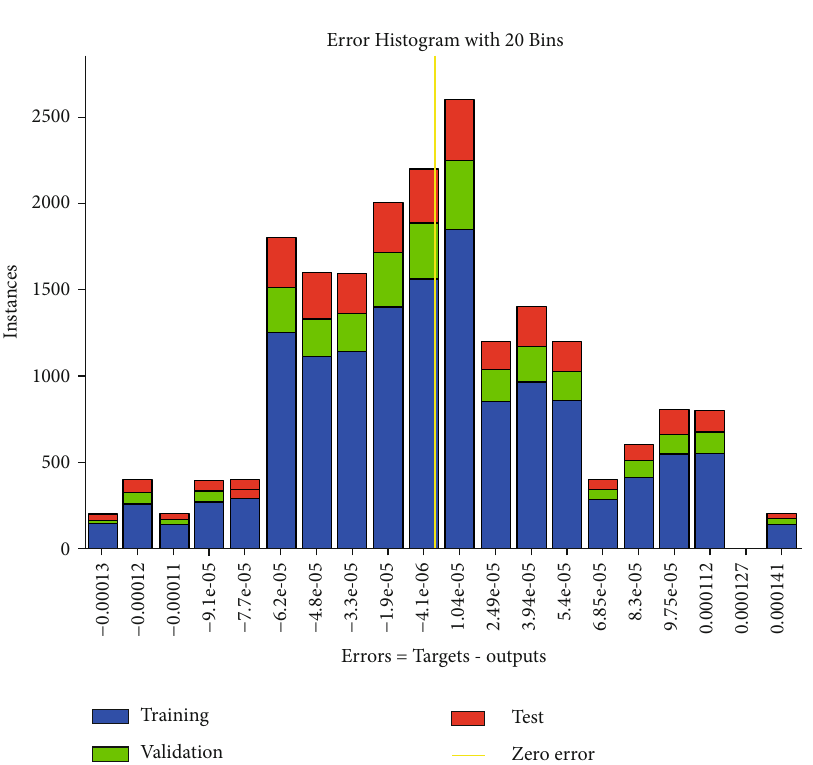
Figure 26: Histogram of DNN-current regulator